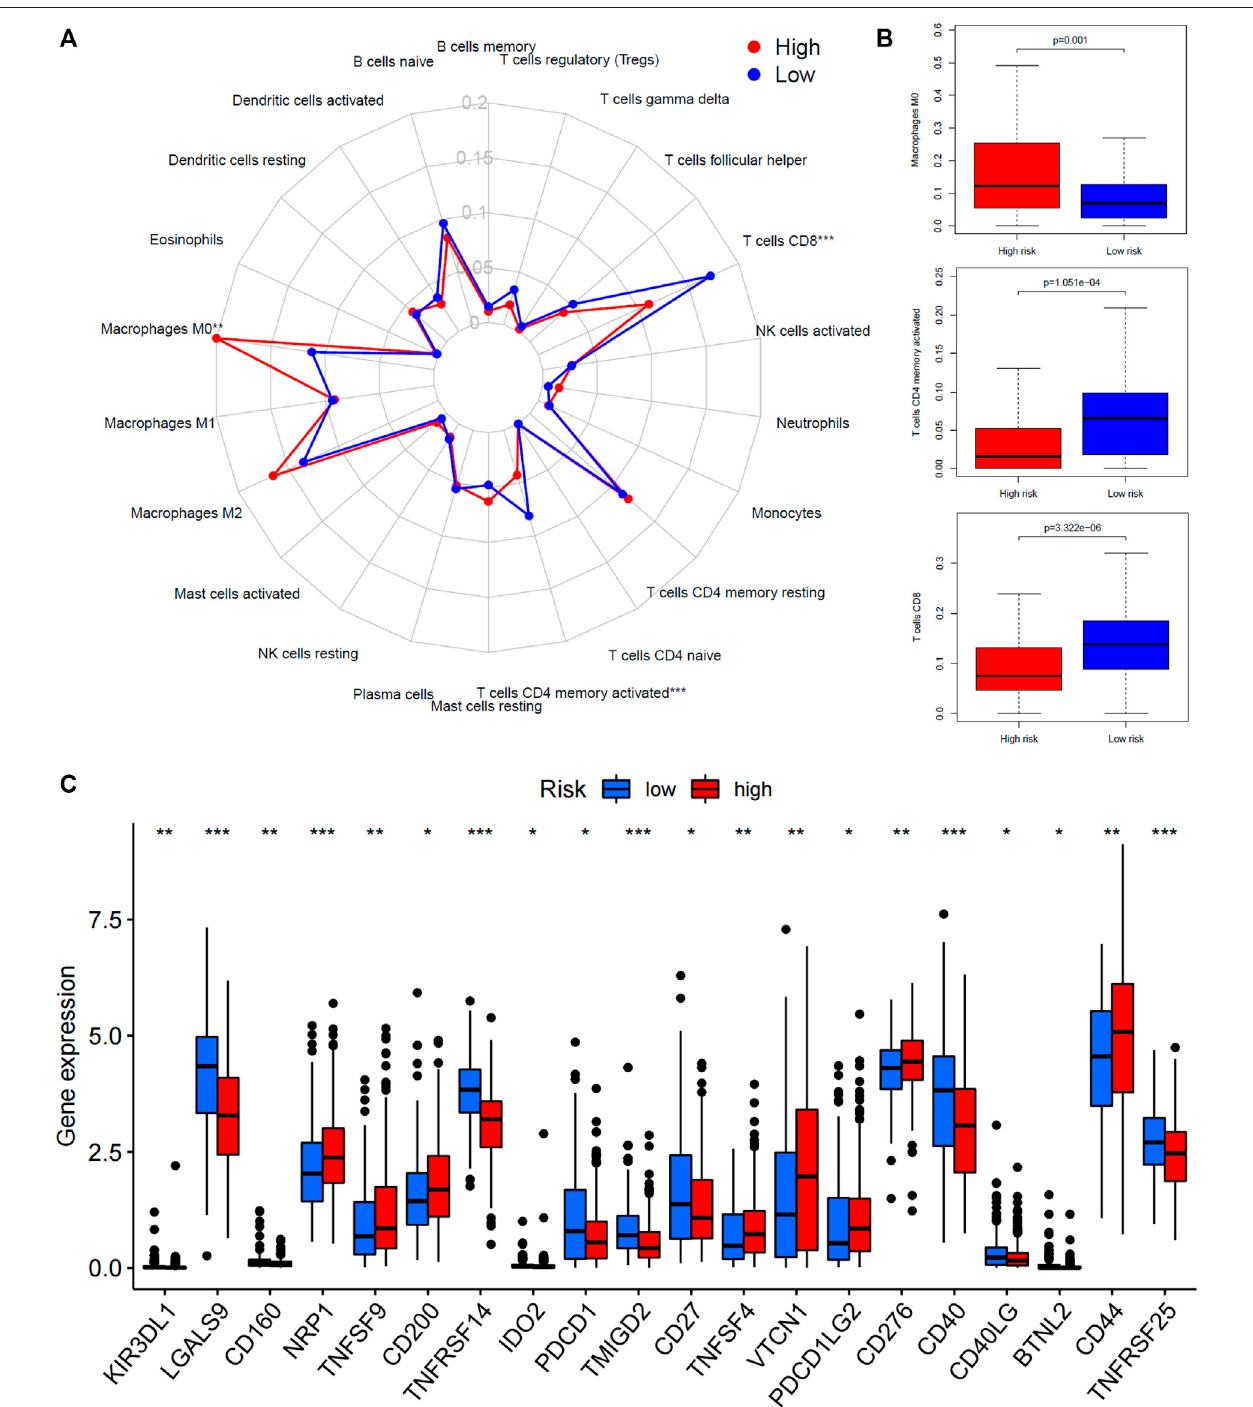
FIGURE 5 | Tumor microenvironment analysis of the 45-IRGP signature. (A) CIBERSORT algorithm comparing 22 types of immune cell in fi ltration between the high-risk and low-risk groups. (B) High-risk group had increased macrophage M0 expression but low-risk group had increased CD8 + T cells plus memory-activated CD4 + T-cell expression. (C) Comparison of immune-checkpoint gene expression between the high-risk and low-risk groups.